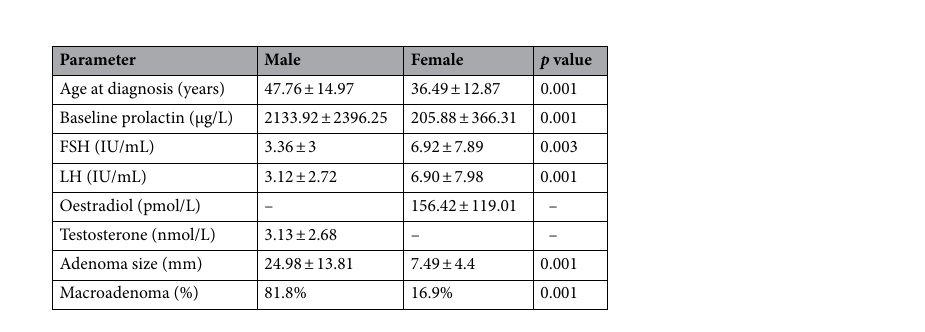
Table 2. Patient characteristics according to gender. FSH Follicle Stimulating Hormone, LH Luteinizing Hormone.